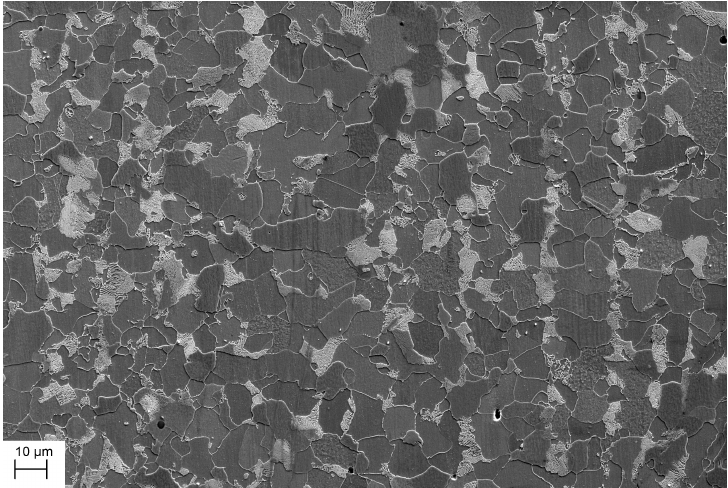
Figure 1. Secondary electron image of the undeformed microstructure. The darker areas are ferrite grains and the lighter areas are pearlite